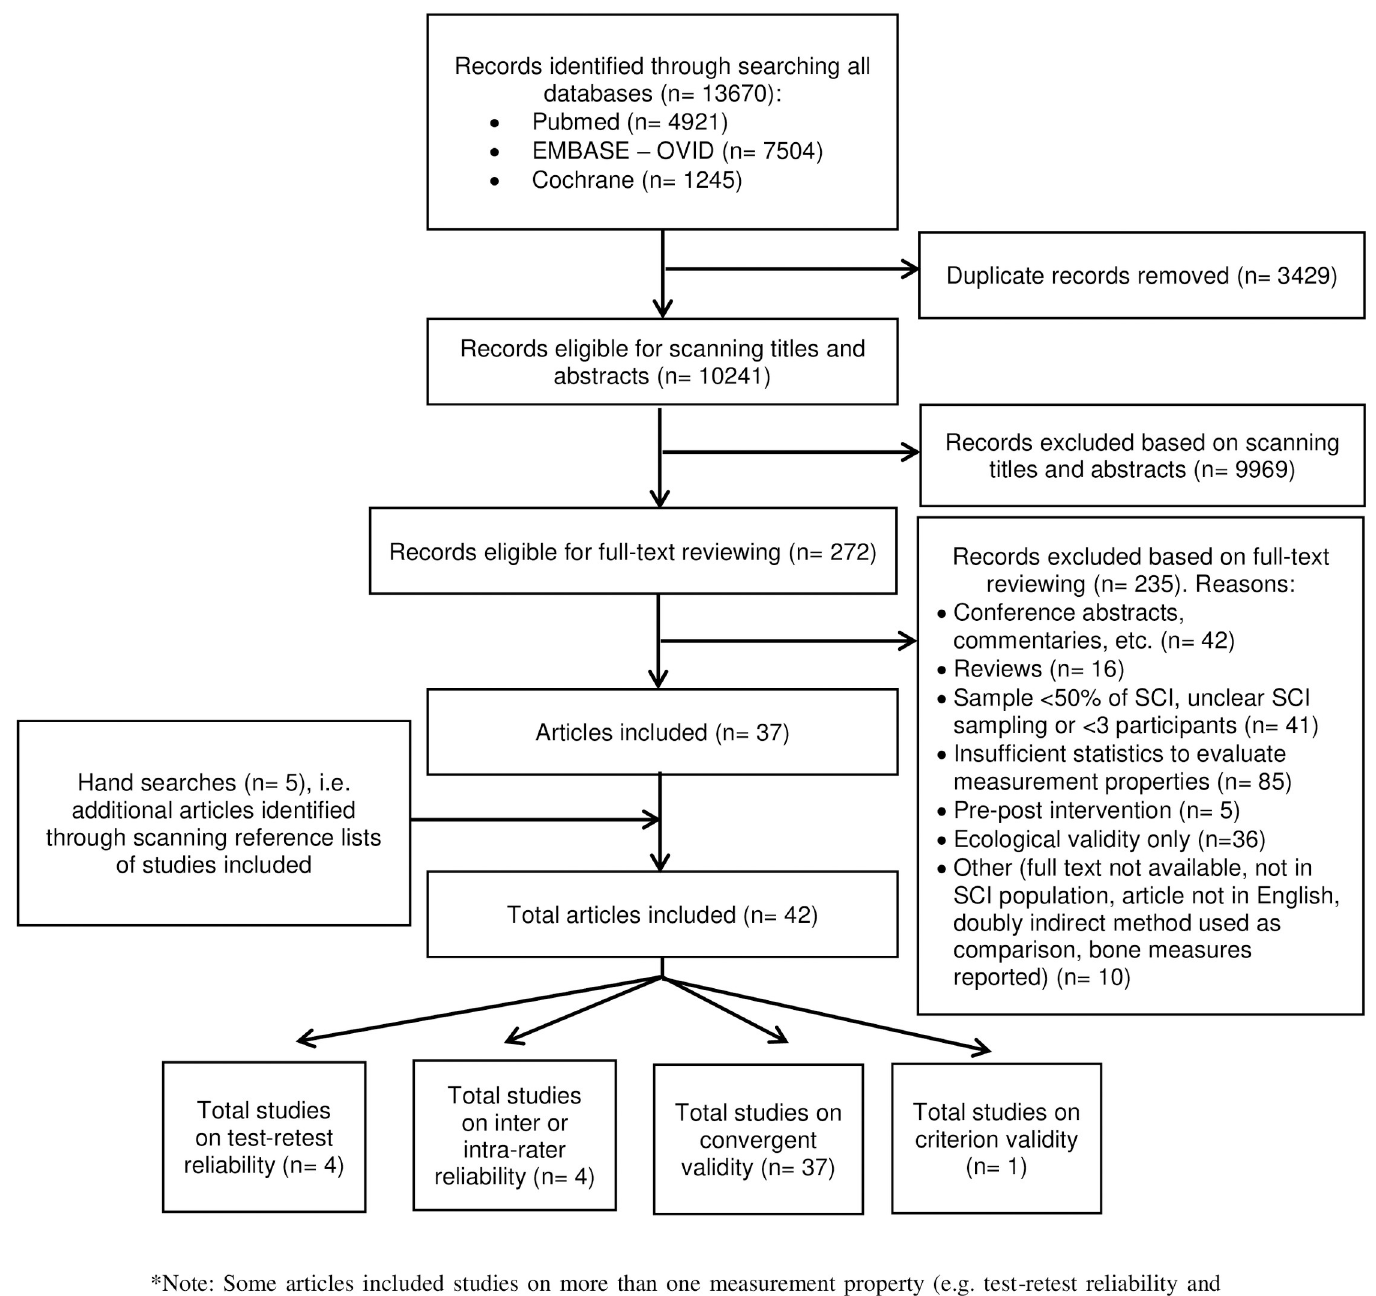
Fig 1. PRISMA flow diagram of the identification of eligible